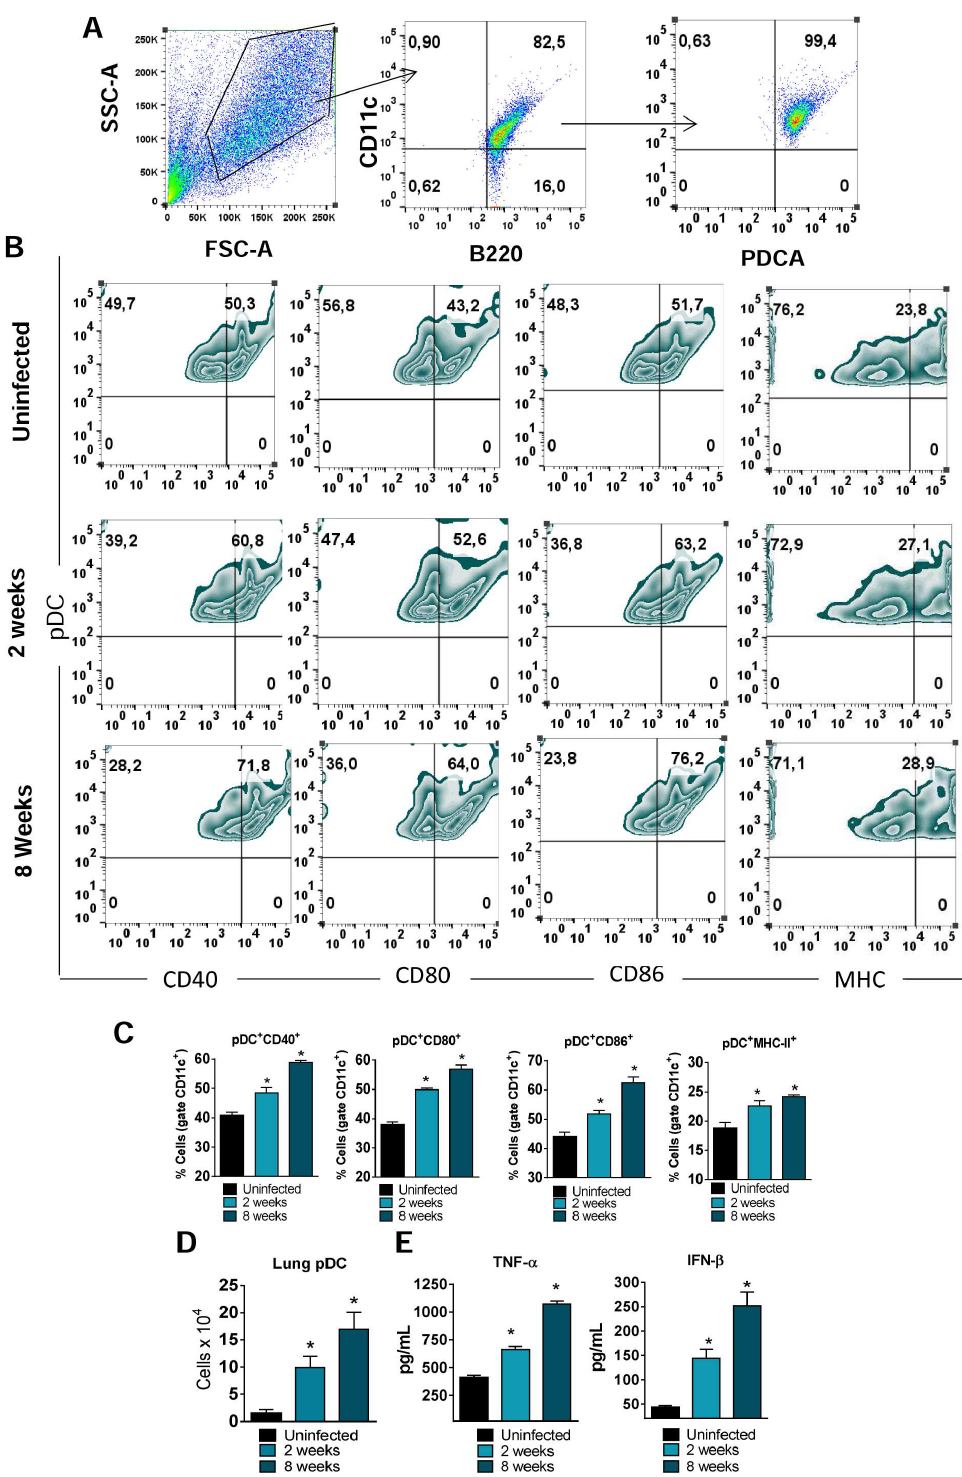
Fig 1. pDC response to P . brasilienis infection The influx of pDCs to the lungs of P . brasiliensis -infected mice (1 × 10 6 yeastscells) was determined by flow cytometry at weeks 2 and 8 post-infection. Lungs were removed, leukocytes obtained and the number of pDCs evaluated. The pDCs were characterized as CD11c + B220 + PDCA + cells as indicated in the gate strategy used (A) and the activation measured by